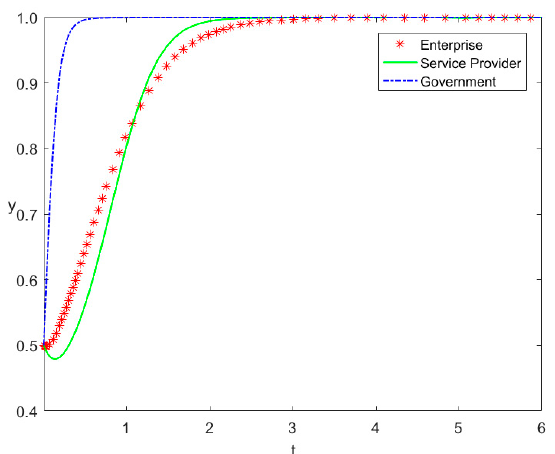
Figure 5. System evolution path diagram under the initial strategy.